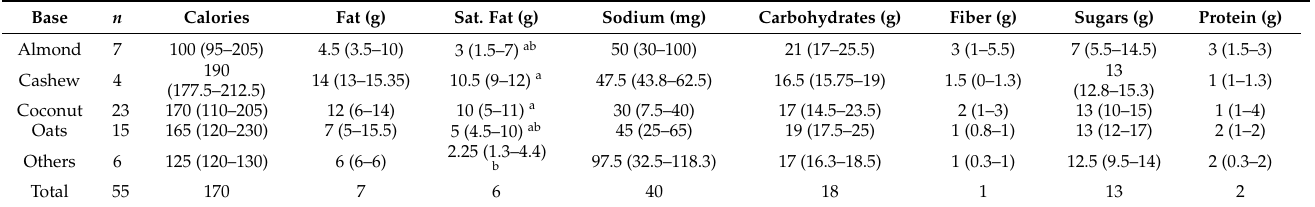
Table 3. The median (Q1–Q3) values of calories and 7 nutrients of non-dairy frozen bars and sandwiches/serving classified according to their